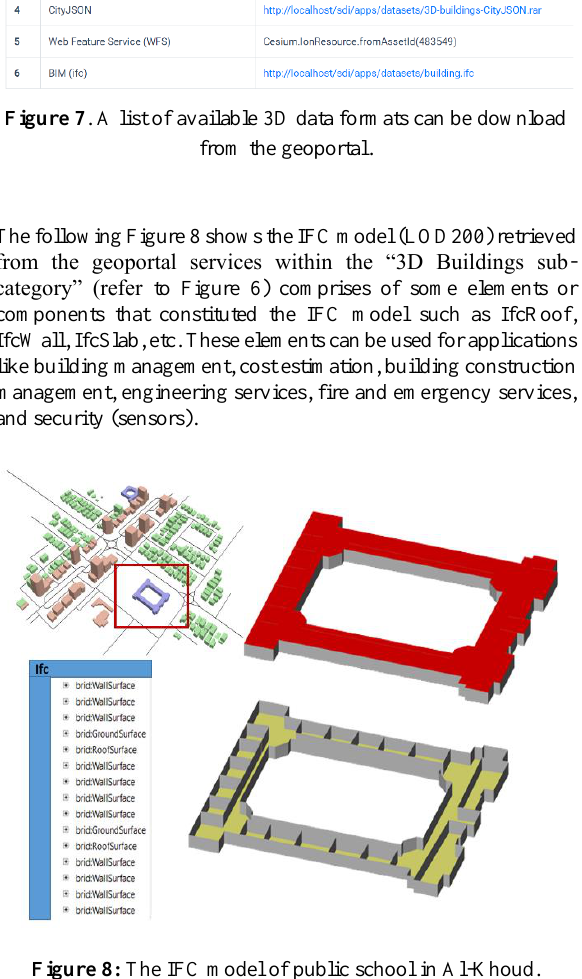
Figure 8: The IFC model of public school in